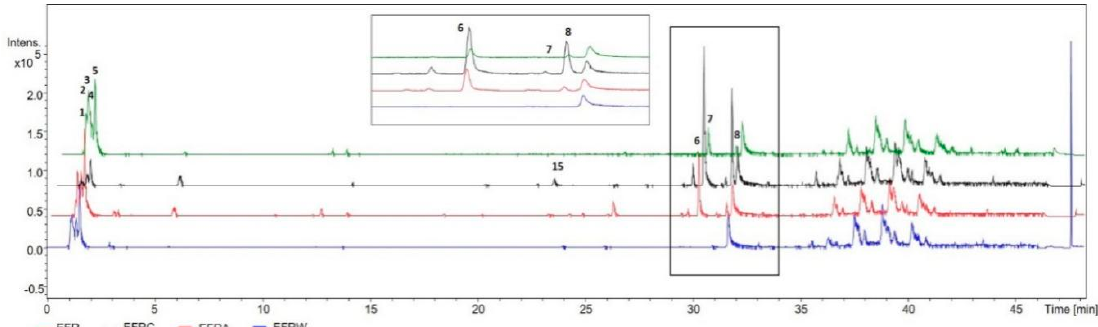
Figure 2. Base peak chromatogram (BPC) obtained by HPLC-DAD-MS of EEF extract and the fractions EEFC (chloroform fraction), EEFA (ethyl acetate fraction), and EEFW (hydromethanolic fraction). The identification of chromatographic peaks is described in Table 1 and all the chromatograms are in the same intensity range.